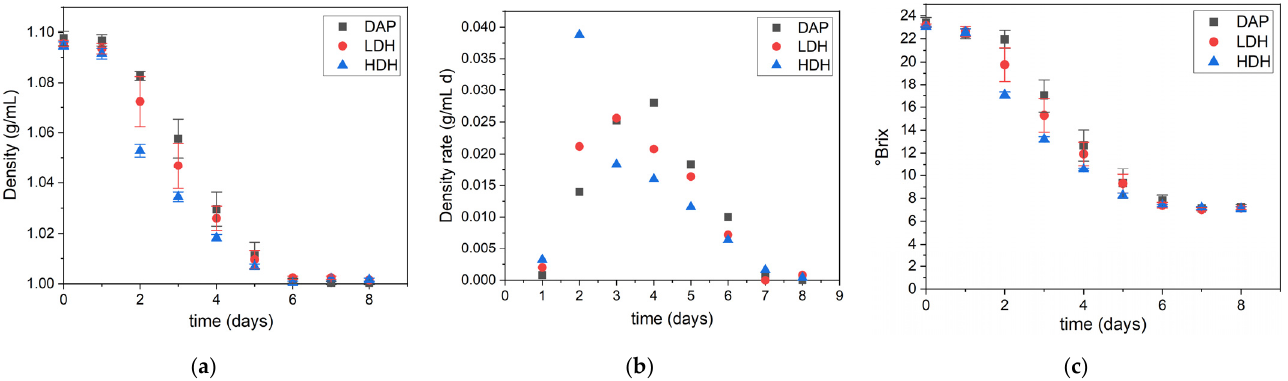
Figure 2. Fermentation progress of Cabernet Sauvignon musts supplemented with different nitrogen sources: ( a ) must density, ( b ) density rate, and ( c ) °Brix versus time.